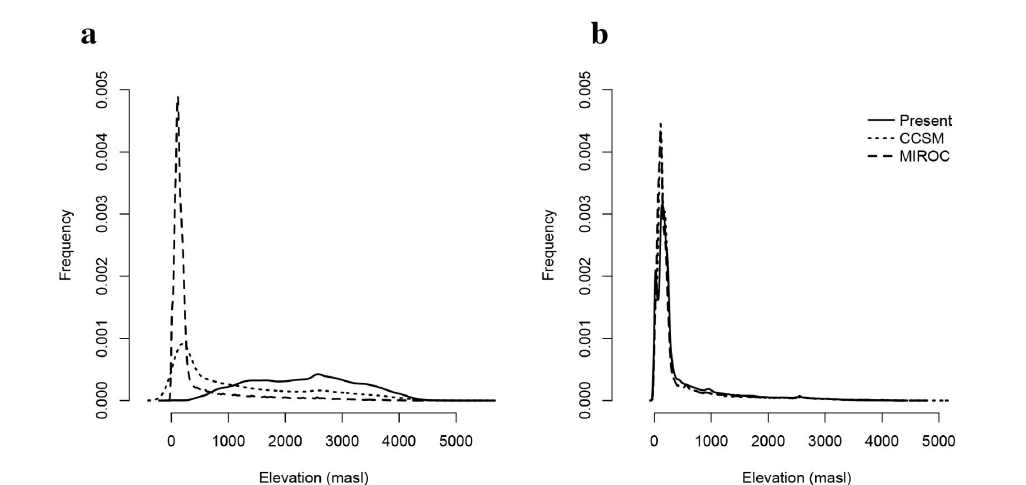
Figure 2. Frequency histograms of each elevation in the species distribution models and retrojections of those models to the last glacial maximum (~21 000 yr) for two selected frog species (of 14 total), one montane ( Dendropsophus molitor Fig. 2a) and one lowland ( Leptodactylus fuscus , Fig. 2b ) in the present and in both past projections, the Community Climate System Model (CCSM) and the Model for Interdisciplinary Research on Climate (MIROC). To obtain elevation values, we generated 10,000 random points in the entire study area and extracted elevation values from points in areas of predicted suitable habitat (binary prediction of 1 with a 10 th percentile training presence threshold). Elevation was obtained from a digital elevation model provided by the WorldClim database (Hijmans et al. 2005). Similar graphs for the other 12 species are in the supplemental material, with highland species shown in Fig. S3 and lowland species in Fig. S4. masl = meters above sea level.